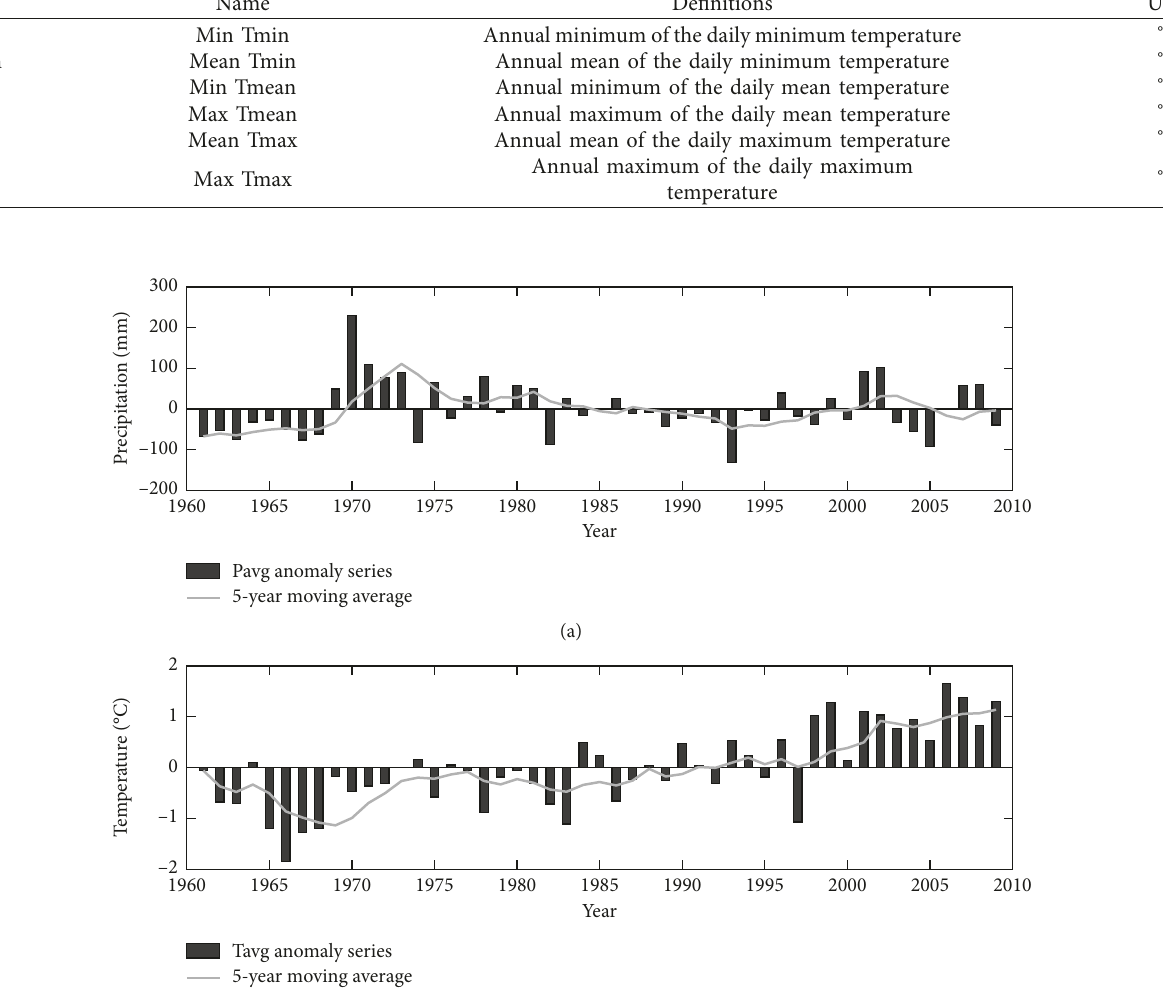
Table 1: Temperature extremes calculated by RClimDex and IDL codes for the period 1961–2009 over the upper reach of the YZRB. ID